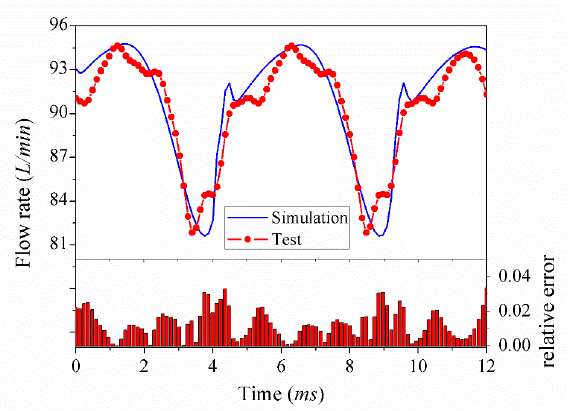
Figure 5. Comparison of discharge flow rate ( p = 20 MPa, n = 1300 rpm)